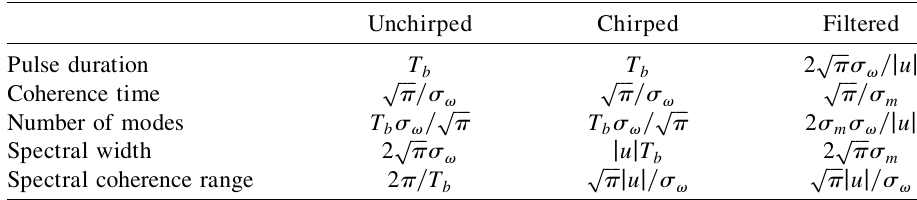
TABLE I. Properties of unchirped, chirped, and filtered SASE. Unchirped Chirped